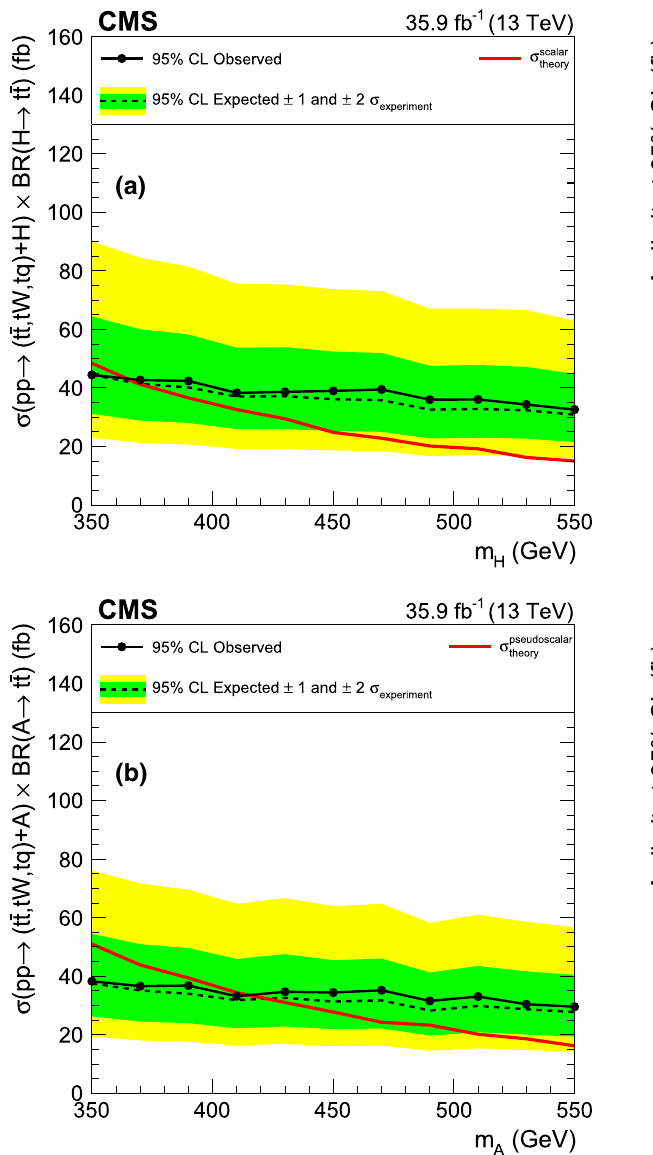
Fig. 8 Limits at 95% CL on the production cross section for heavy scalar ( a ) and pseudoscalar ( b ) boson in association to one or two top quarks, followed by its decay to top quarks, as a function of the (pseudo)scalar mass. The red line corresponds to the theoretical cross section in the (pseudo)scalar model